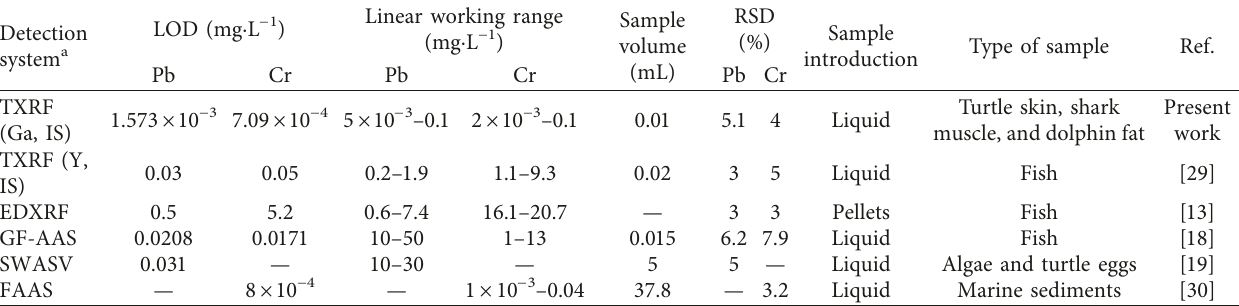
Table 3: Comparison between the TXRF methodology and other methodologies for the simultaneous determination of Pb and Cr. Detection system